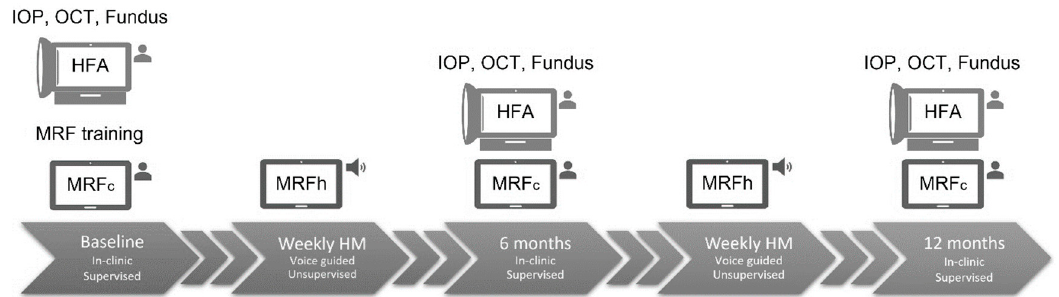
Figure 1. Experiment timeline. In-clinic visits were conducted at baseline, 6 months and 12 months with weekly home monitoring in between. HFA = Humphrey Field Analyzer; MRFc = Melbourne Rapid Fields performed under clinical supervision; MRFh = Melbourne Rapid Fields performed at home under voice guidance; IOP = intraocular pressure; OCT = optical coherence tomography.